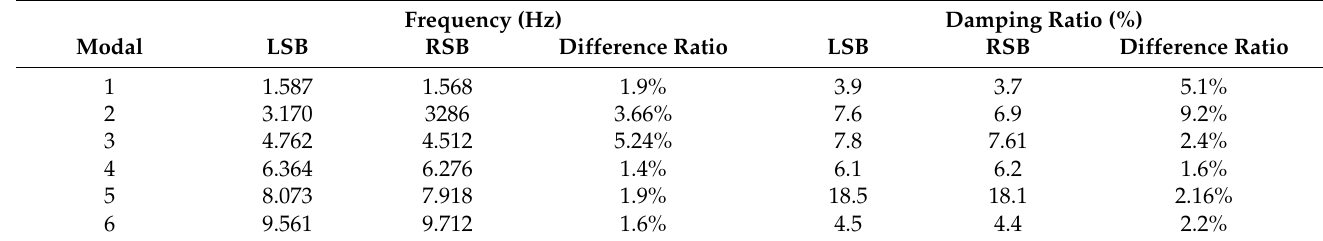
Table 8. Modal parameters identified at distance of about 5